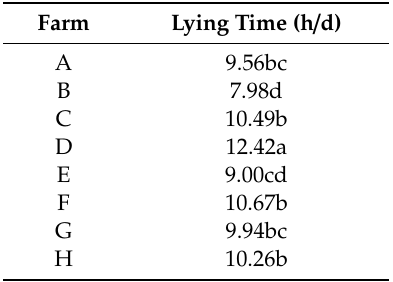
Table 4. Lying time (h / d) per farm during H_S.